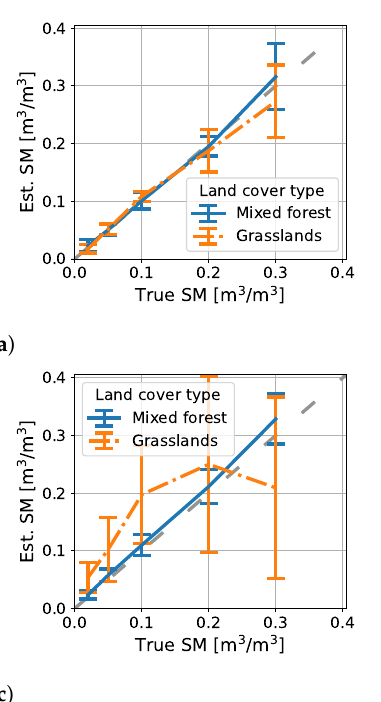
= 20°, for the two land i